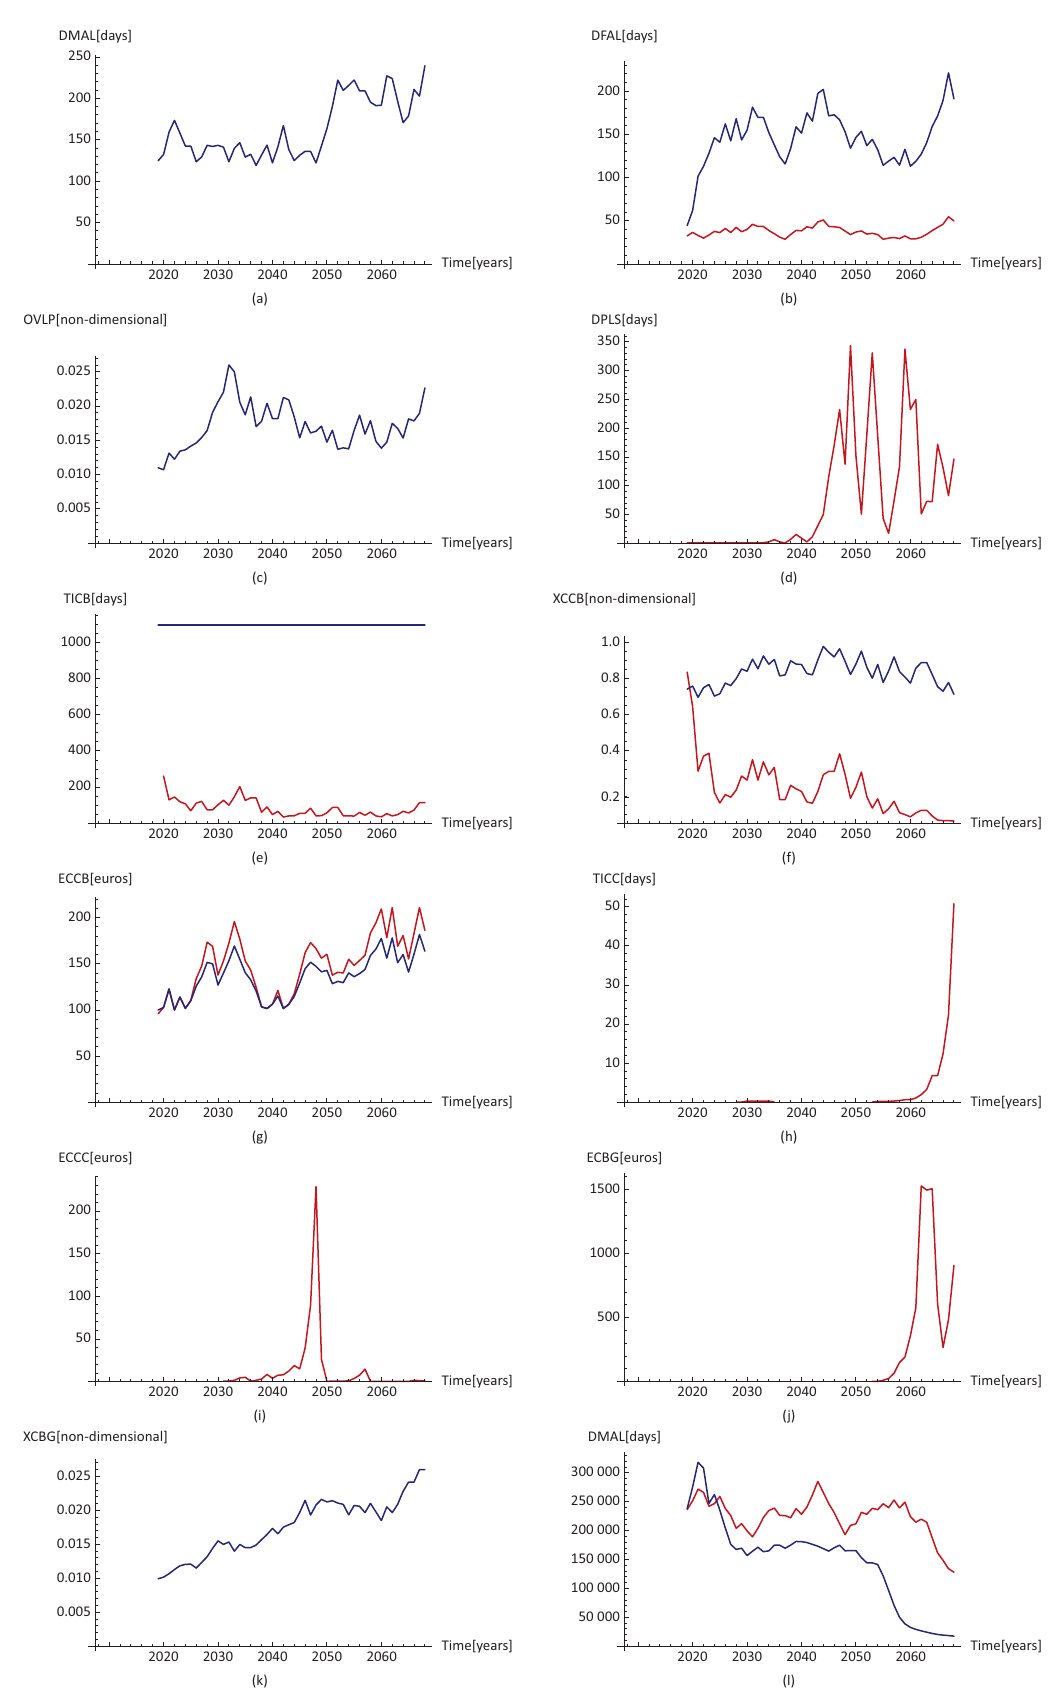
Figure 2. Future simulation (genetic algorithm) of family policies (disaggregated): Spain, 2020–2060. Notes: The GA1 (free) is presented in red and the GA2 (conditional on goals consistency) is presented in